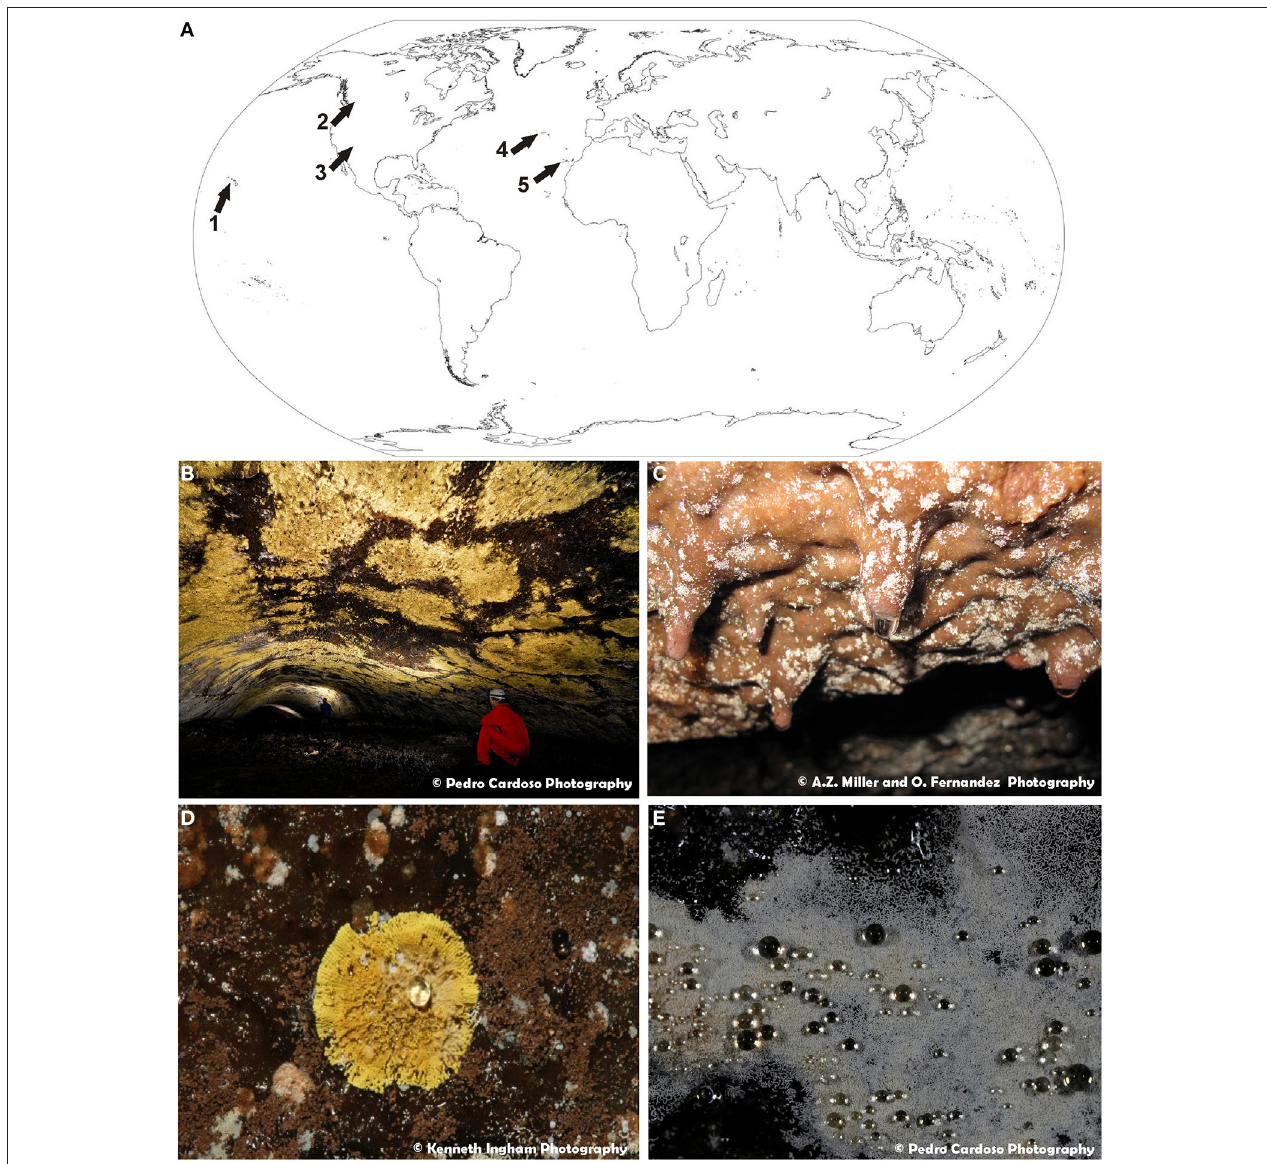
FIGURE 1 | (A) World map of volcanic caves studied in this work: 1—Hawaiian volcanic caves (U.S.A.); 2—Helmcken Falls Cave, British Columbia (Canada); 3—New Mexico volcanic caves (U.S.A.); 4—Azorean lava caves (Portugal); 5—La Palma caves, Canary Islands (Spain). (B) General view of extensive yellow microbial mats from Gruta da Terra Mole (Azores, Portugal). (C) General view of white colonies forming dendritic branches on basaltic lava from Fuente de la Canaria cave (La Palma Island, Spain). (D) Close-up view of a yellow colony from Gruta dos Montanheiros (Azores, Portugal). (E) Close-up view of white microbial mat covered with water droplets from Gruta da Terra Mole (Azores,